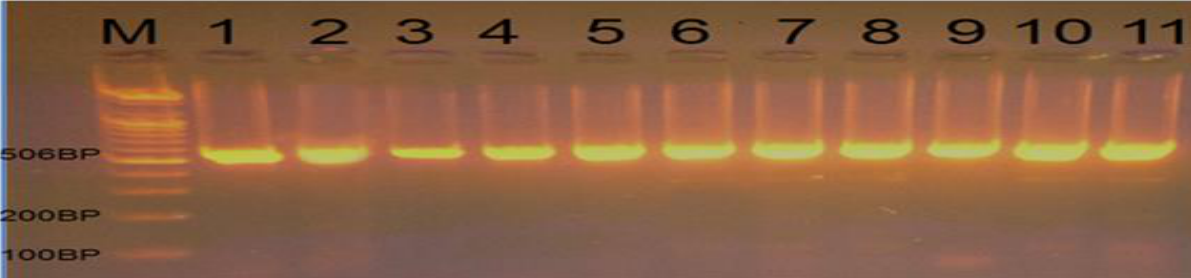
Figure, 4: PCR amplification of the invA gene in 11 Salmonella isolates. Lane 1-11 represents Salmonella isolates, lane M represent molecular weight marker, 100 bp